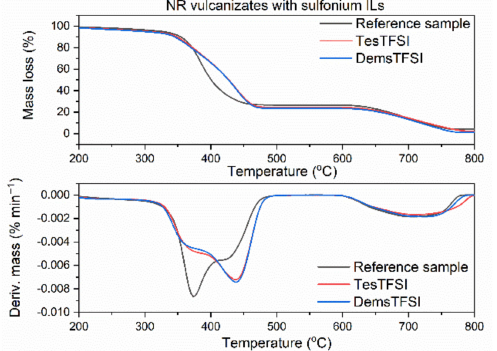
Figure 8. TG and DTG curves of the NR vulcanizates containing sulfonium ILs with TFSI